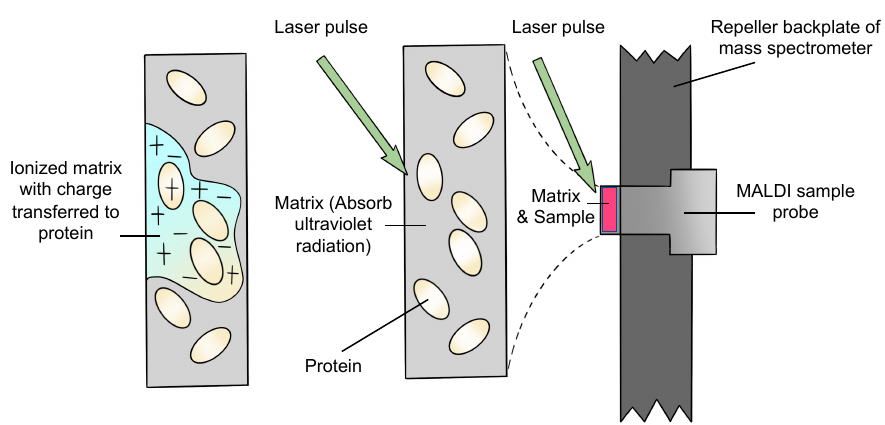
Figure 1. Schematic diagram of the general procedure of ionization.